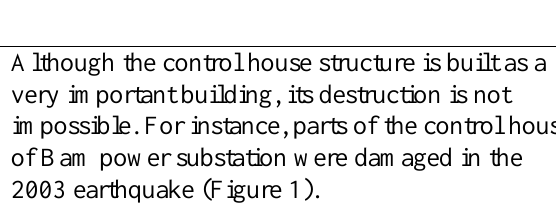
Table1. Observed damages of power substation components in some previous earthquakes of Iran Main sections of